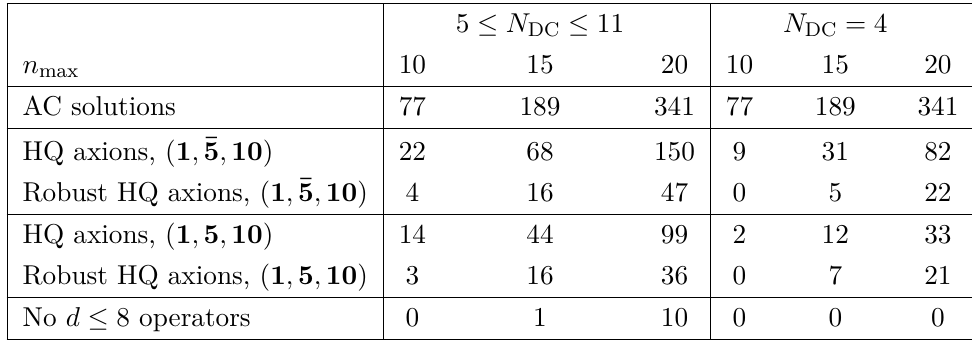
Number of ( 1 , ¯5 , 10 ) and ( 1 , 5 , 10 ) GUT models with ∆ (cid:8)(cid:8) = 12 and integer charges PQ satisfying | p . Models are found through a numerical scan of the parameter space for i | , | q i | ≤ n max different values of n and 4 ≤ N 11 . The counting is made identifying solutions that are max DC ≤ equal up to an overall factor or by exchanging p . The first row indicates the total number of i ↔ q i independent solutions of the Anomaly Cancellation (AC) conditions of eq. (5.1), while the following rows list how many of these solutions yield High Quality (HQ) models, either with a minimal GUT sector or for generic GUT scalar sectors (robust models). The last row shows the number of models with no flavor-violating operators with dimension d ≤ 8